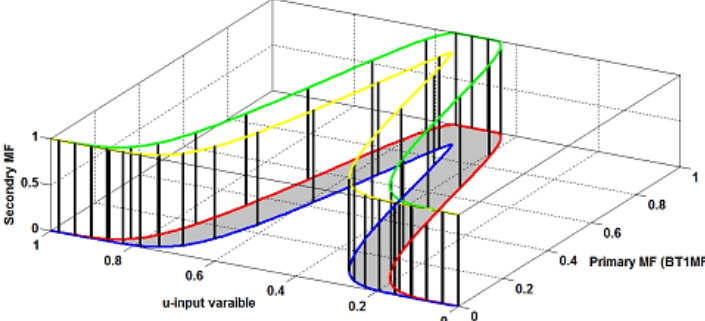
Fig. 2. 3D representation of the interval type-2 membership function